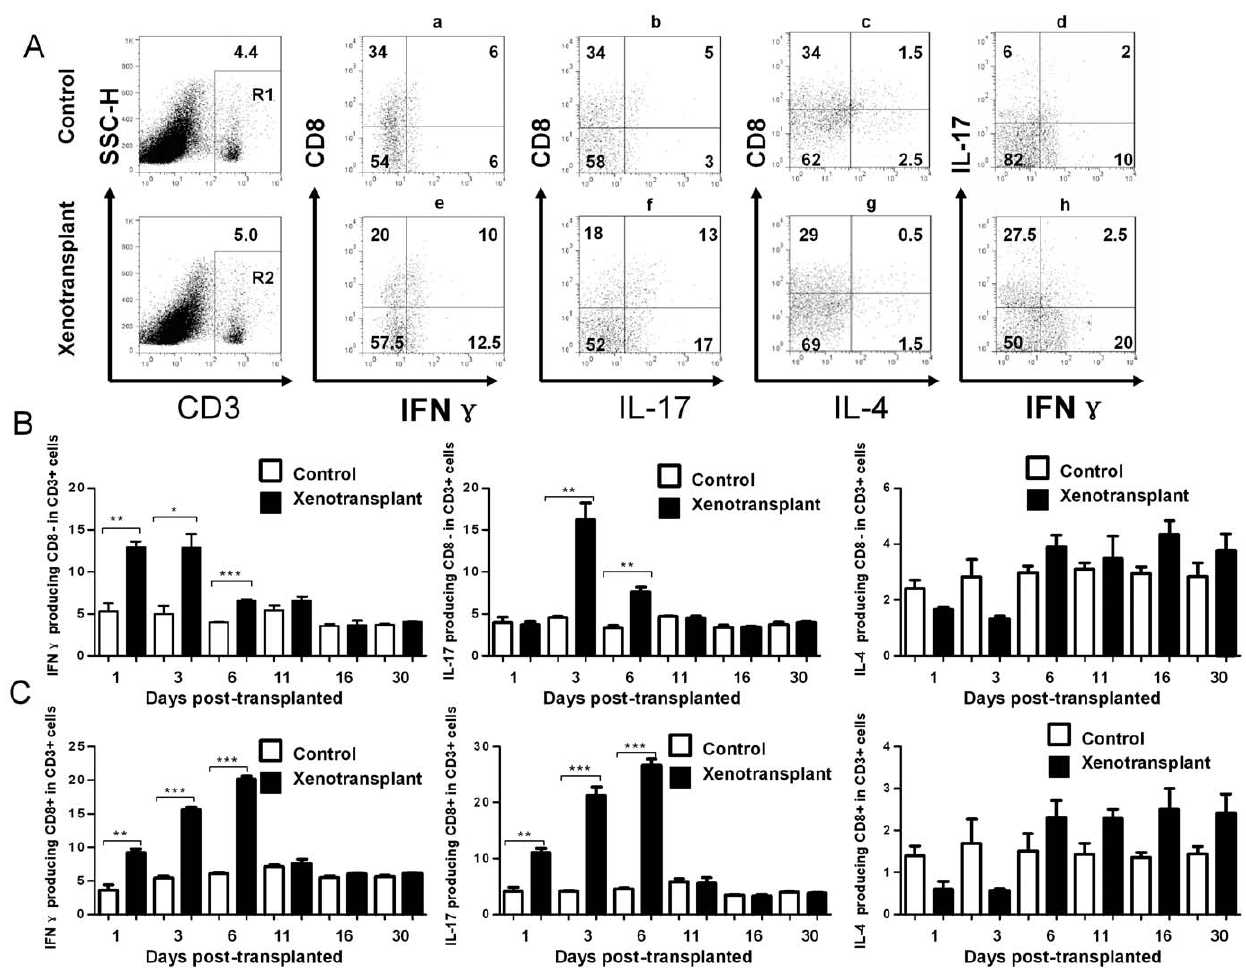
Figure 4. Flow cytometry analysis of IFN- c , IL-17 and IL-4 in lymphocytes from spleen. Spleens were collected at each time point from xenotransplanted mice (day 1, 3, 6, 11, 16, and 30) and sham controls, and used for flow cytometry analysis (A) Representative data of IFN- c , IL-17 and IL-4 expression in lymphocytes from spleen at day 1. Graph a, b, c and d are gated from R1; e, f, g, and h are gated from R2. (B) Percentage of CD3 + CD8 2 T cells expressing IFN- c , IL-17 and IL-4 at days 1–30 were averaged and graphed. IFN- c expression increased from day 1 to day 6, and decreased to control levels by day 11. IL-17 expression increased at day 3 and lasted until day 6, and decreased to control levels by day 11. There is no significant difference of IL-4 producing CD3 + CD8 2 T cells between recipients and control group. *, p , 0.05; **, p , 0.01; *** p , 0.001. (C) In CD3 + CD8 + T cells, IFN- c and IL-17 expression increased from day 1 to day 6, and decreased to control levels by day 11. There is no significant difference of IL-4 producing CD3 + CD8 + T cells between recipients and control group. *, p , 0.05; **, p , 0.01; *** p , 0.001. (We performed this experiment twice).